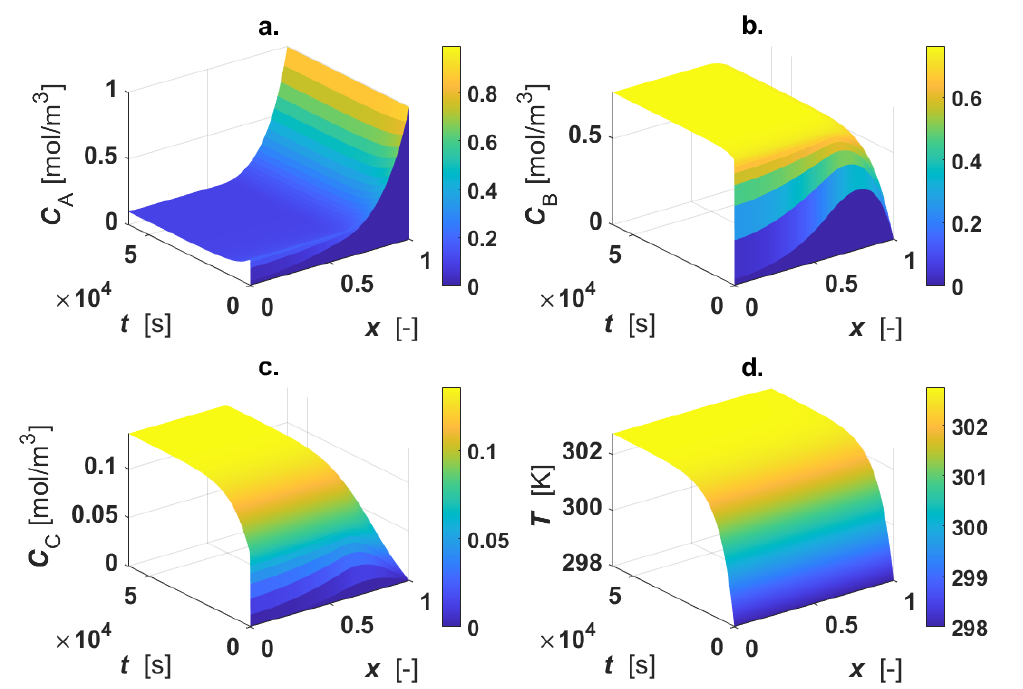
Figure 3. Intraparticle profiles for egg-shell catalyst. Calculated profiles for: ( a ) C A ; ( b ) C B ; ( c ) C C ; ( d ) T. Color-bar of each plot is located on the right-hand-side.